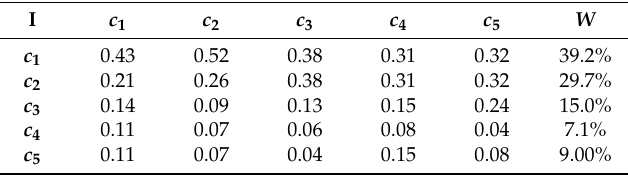
Table 7. Normalization of the matrix and resultant vector of weights W